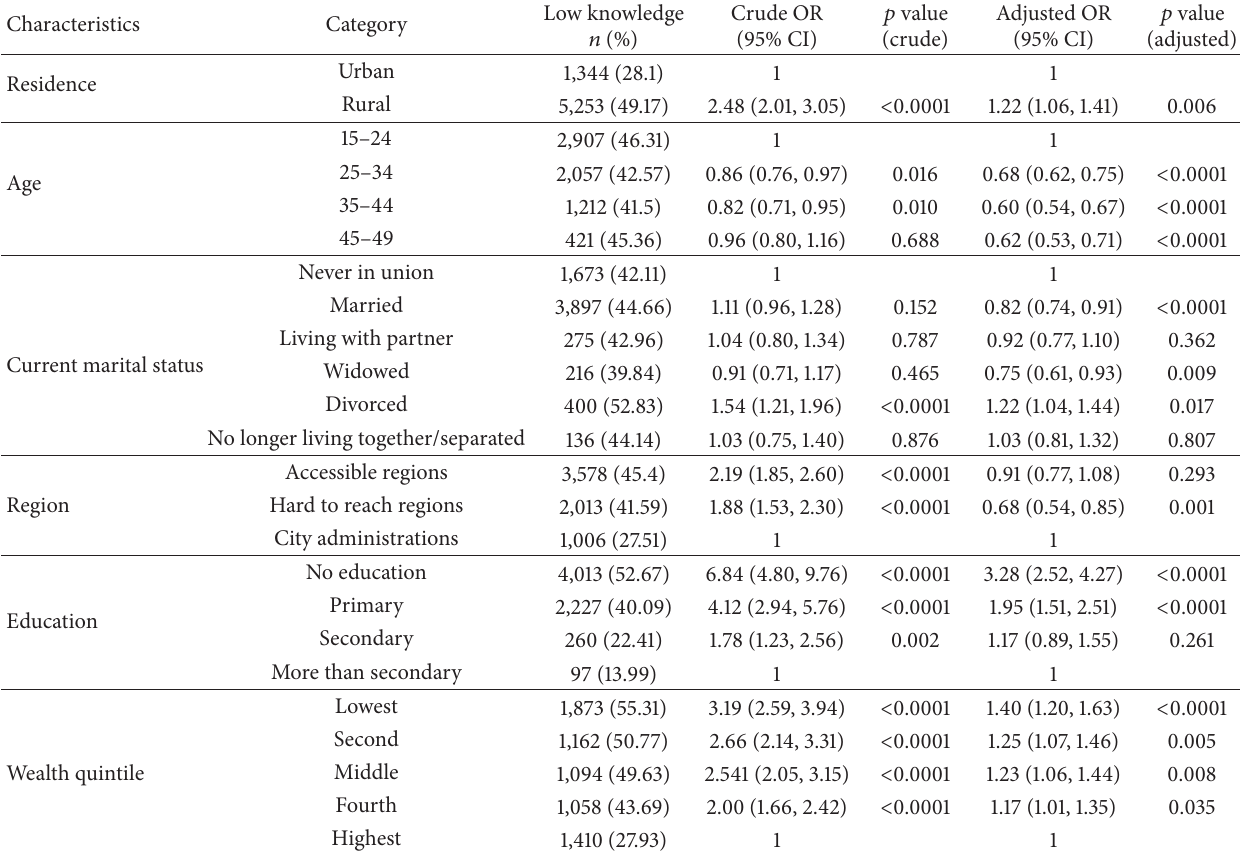
Table 4: Factors associated with low TB knowledge among women, Ethiopia 2011.